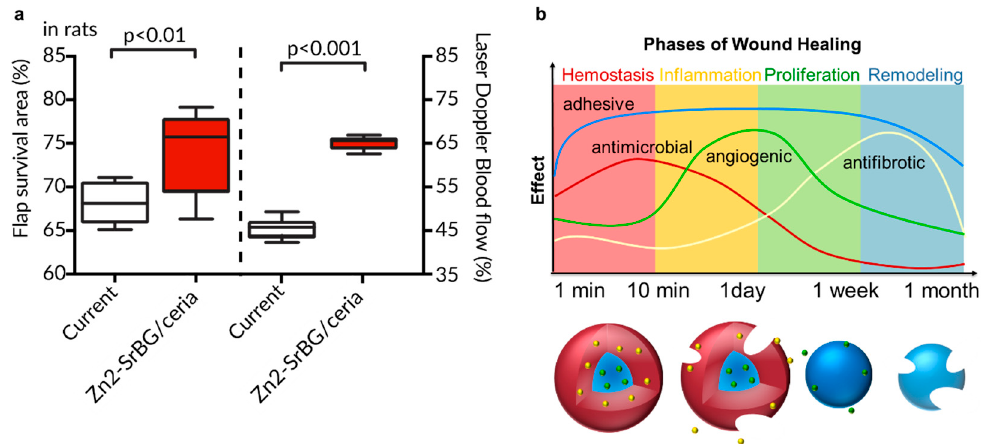
Figure 6. ( a ) A combined architectural approach, i.e., Janus-shaped hybrid nanoparticles made out of cerium oxide and Zn-doped Sr-substituted bioglass increased skin flap survival in a rat model. The increased survival area was most likely due to the angiogenic properties of the nanoparticles and the resulting higher tissue perfusion (adapted from Lese at al. [108]). ( b ) By engineering the architecture and structure of a metal oxide nanotherapeutic, the temporal control of material activity can be achieved. This control allows the synchronization of the desired e ff ect to the desired